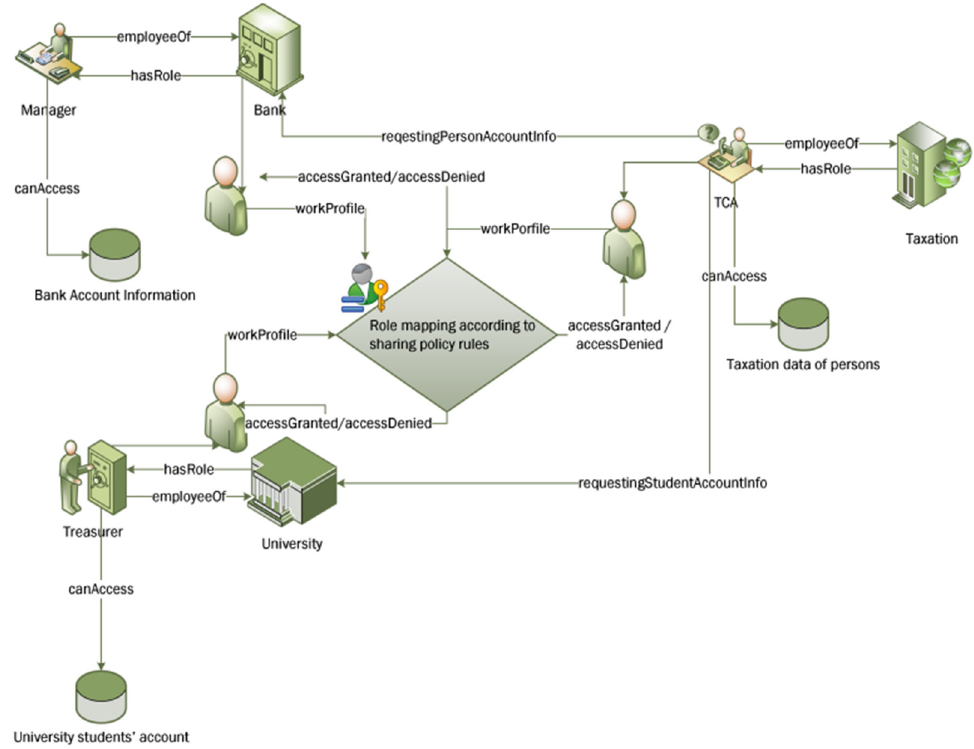
Figure 8. Collaborative environment used in experimental scenarios.